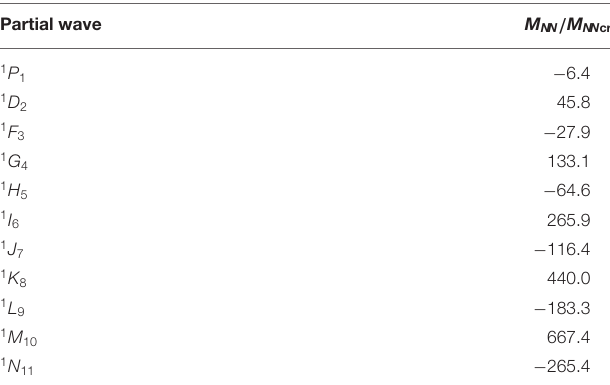
TABLE 2 | Estimate of the critical strength M − 1 NN cr of the Yukawa potential in the lowest 2 N singlet channels above which OPE cannot be treated perturbatively